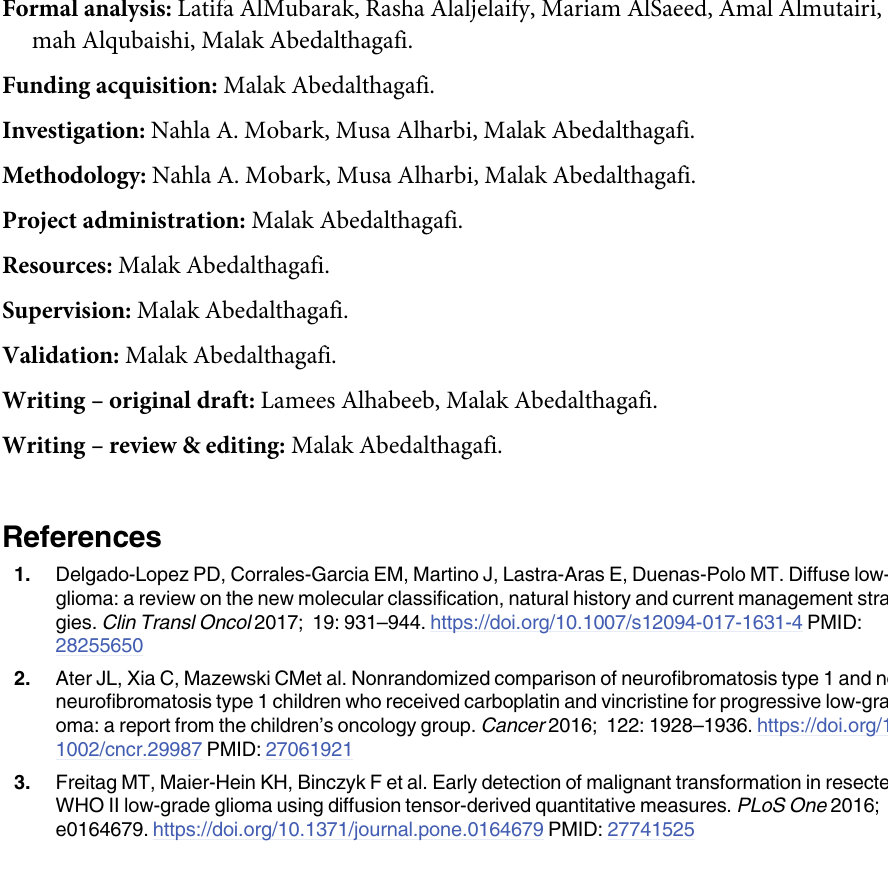
S2 Fig. Gene targets in the Oncomine Assay in which identified pLGG mutants are highlighted. S1 Table. Complete patient demographics. S2 Table. Genetic landscape of LGG tumors.